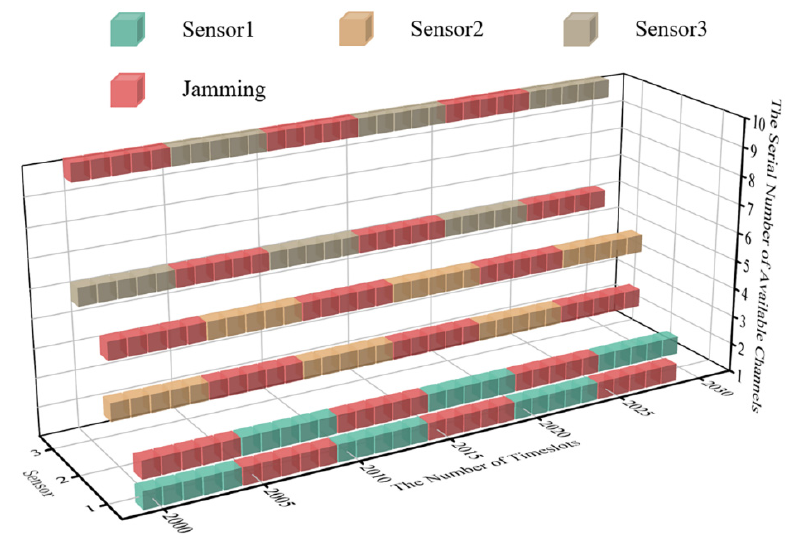
Figure 10. The cubic diagram of DAJA’s convergent state.